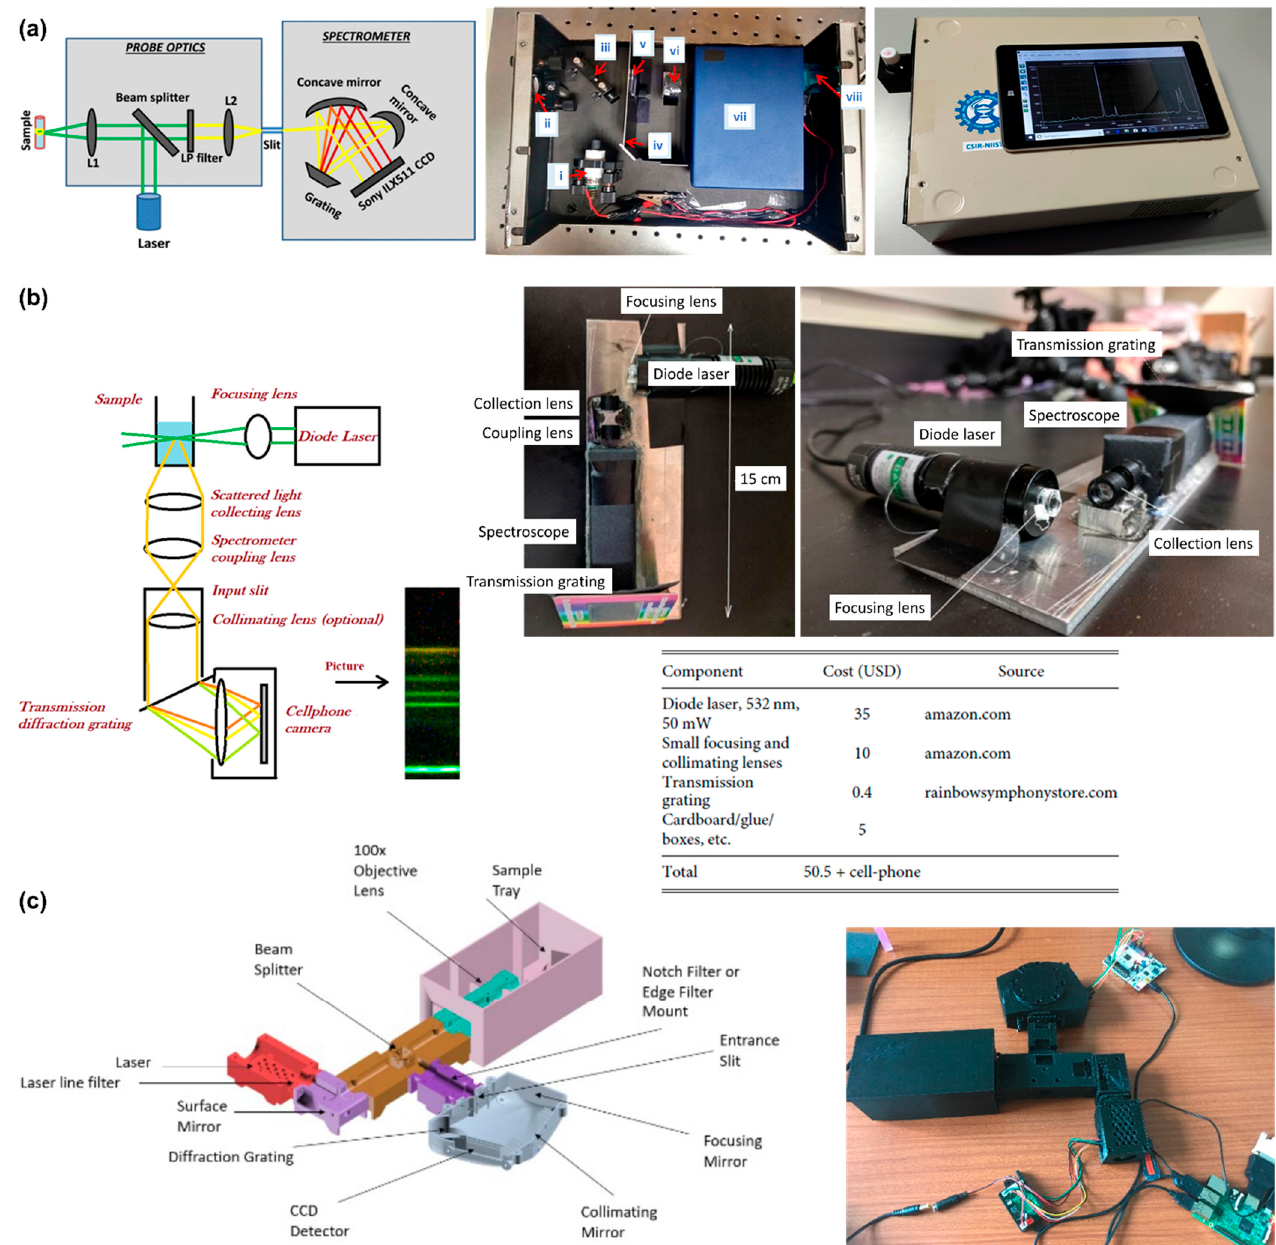
Figure 6. Portable cost-effective Raman spectrometer models. ( a ) Schematic representation of an inexpensive Raman spectrometer ( left ), Components ( middle ): (i) Laser diode, (ii) Focusing lens, (iii) Beam splitter, (iv) Beam block; to prevent interference from the reflected laser and room light, (v) Long-pass filter, (vi) Focusing lens, (vii) Spectrometer, and (viii) RS232 to USB for GUI device, Exterior view ( right ). Reproduced with permission from ref. [72]. Copyright 2021 American Chemical Society. ( b ) Cellphone-based Raman spectrometer constructed from a diffraction grating and cellphone-camera system for in situ detection. Schematic of the spectrometer setup ( left ), top and front view of the system with the parts labeled ( right ), and the expenditure of the components and materials used ( below ). Reproduced with permission from ref. [73]. Copyright 2021 American Institute of Physics (AIP). ( c ) A low-cost, easy-to-handle, Raman spectrometer built with commercial electronics and optics, and 3D printing. A computer-aided design of the 3D printed Raman Spectrometer ( left ) and the corresponding setup ( right ). Reproduced under the Creative Common Attribution 4.0 License (CC BY 4.0) from ref. [74]. Copyright 2018, The Authors, published by CERN.